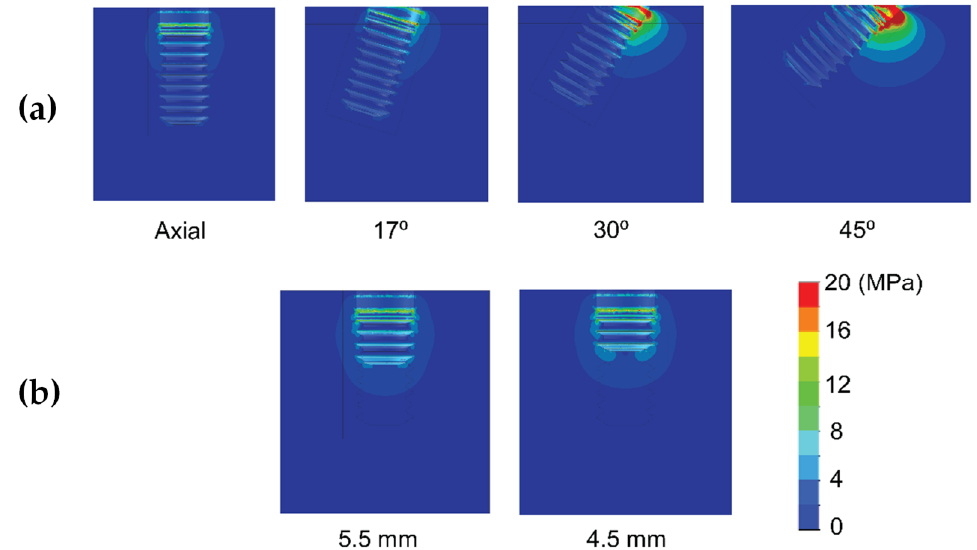
Figure 6. Von Mises stress distribution of immediately-loaded long (10 mm) implant ( a ) and short implants (4.5 and 5.5 mm in length) ( b ) in bone type 0-I.